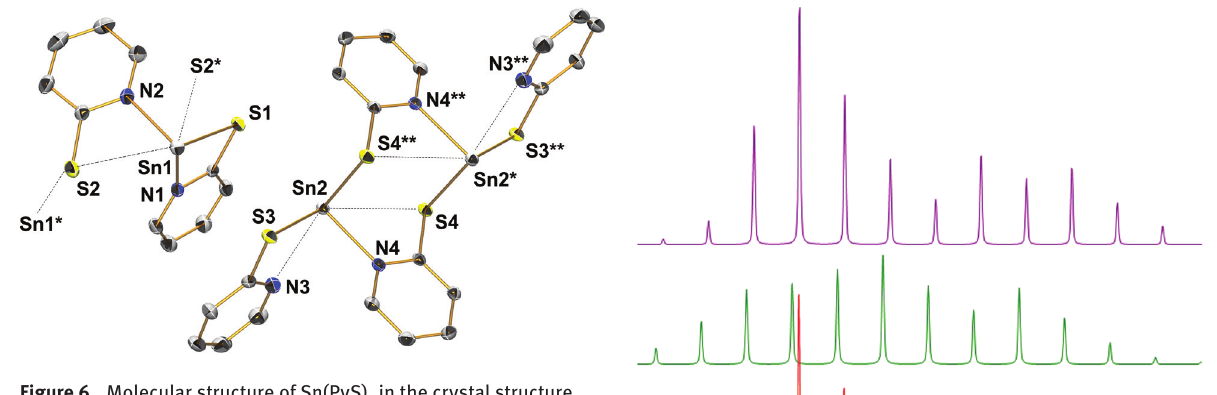
Figure 6 Molecular structure of Sn(PyS) ORTEP/POV-RAY diagrams (Farrugia, 1997; POV-RAY 3.6, 2004) with thermal displacement ellipsoids are shown at the 50% probability level. Selected atoms are labeled and hydrogen atoms are omitted for clarity. The asymmetric unit comprises two independent Sn(PyS) Symmetry-related atomic sites are indicated by * (for the shift along a